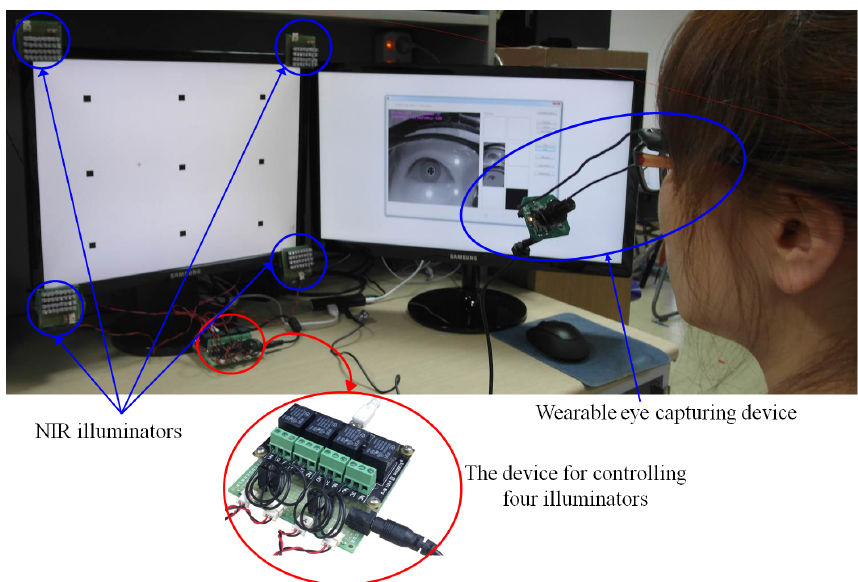
Figure 1. Proposed gaze tracking